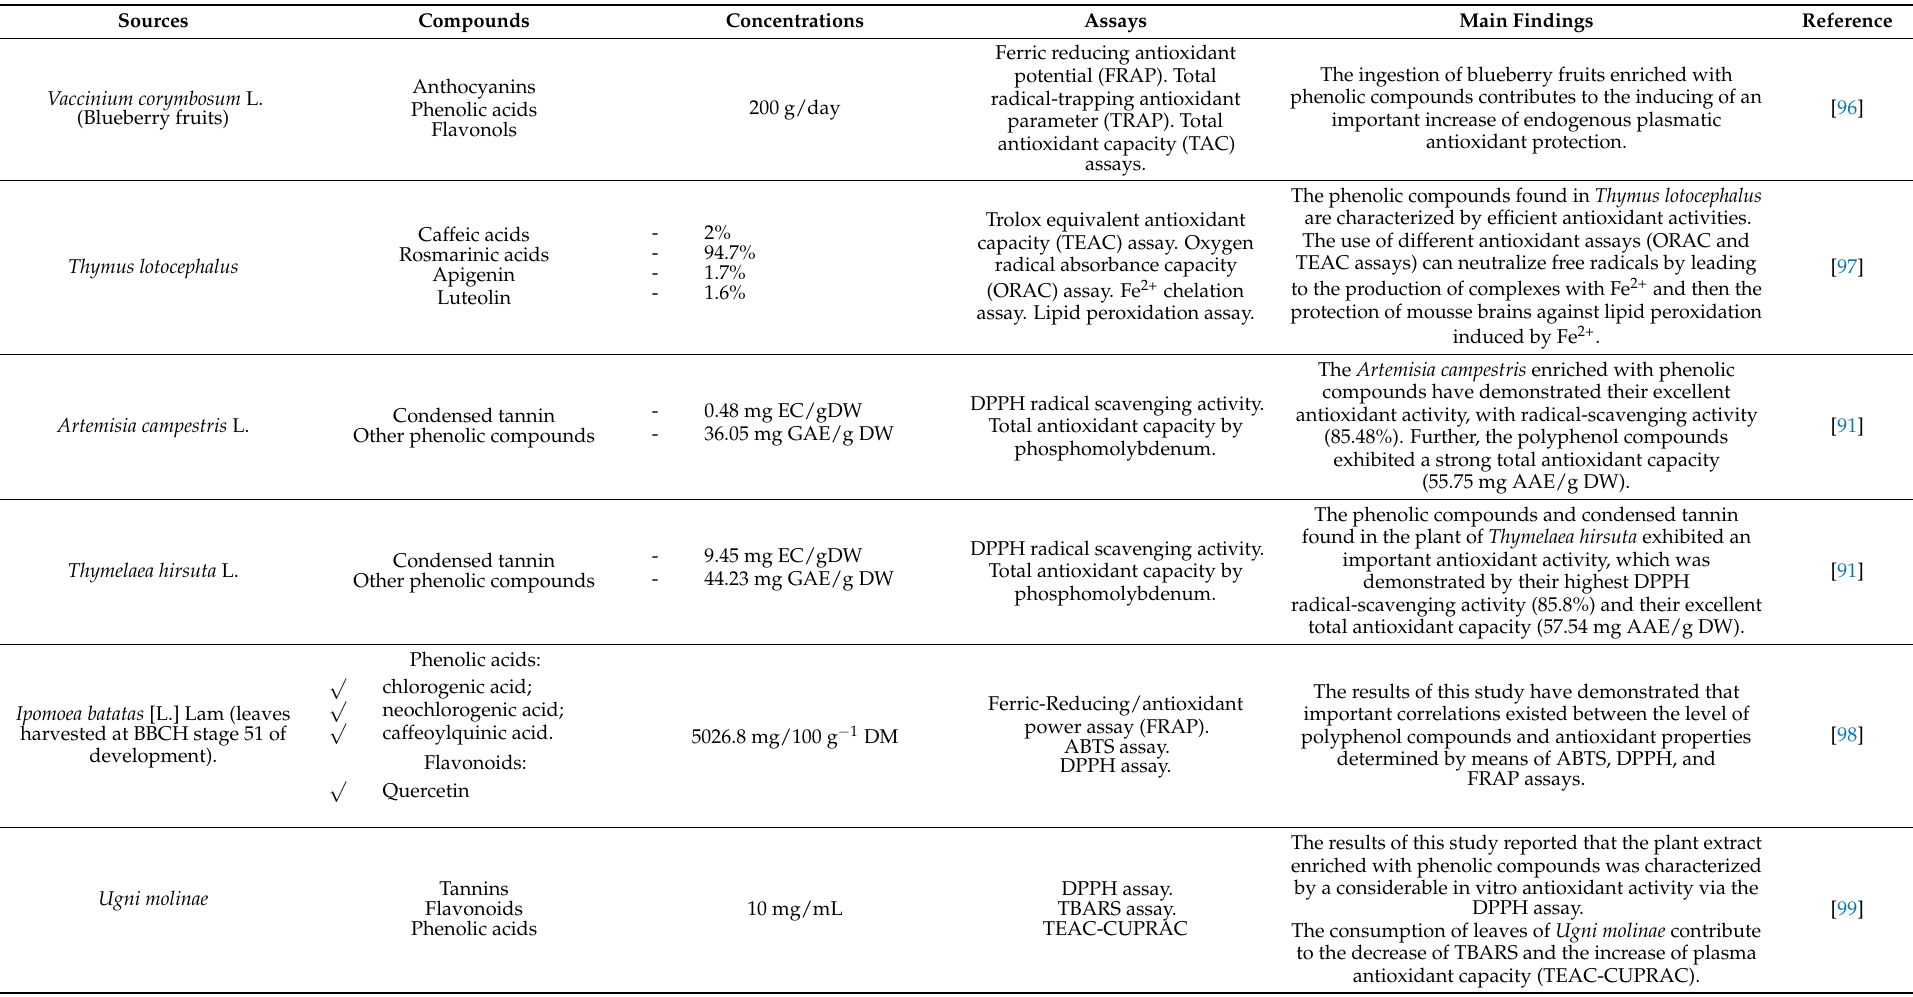
Table 2. Antioxidant activity of some phenolic